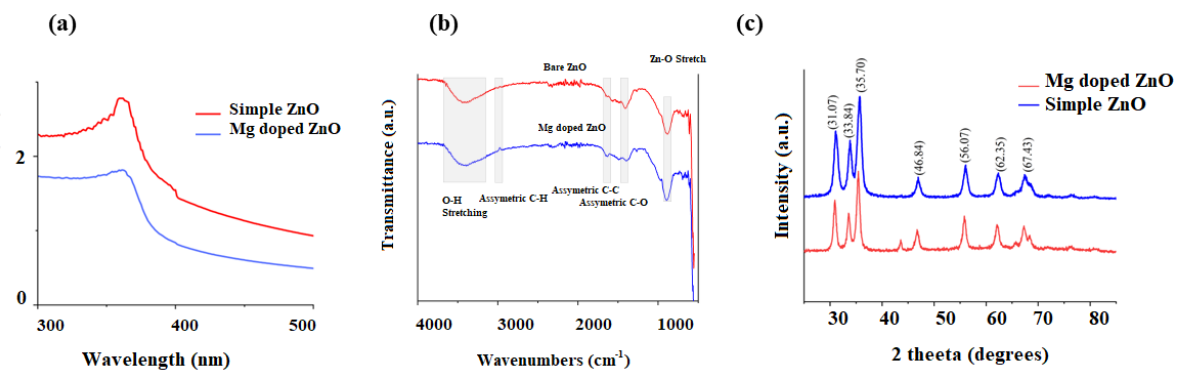
Figure 1. ( a ) UV-vis analysis, ( b ) FTIR analysis, and ( c ) XRD analysis of bare and Mg-doped ZnO NPs.